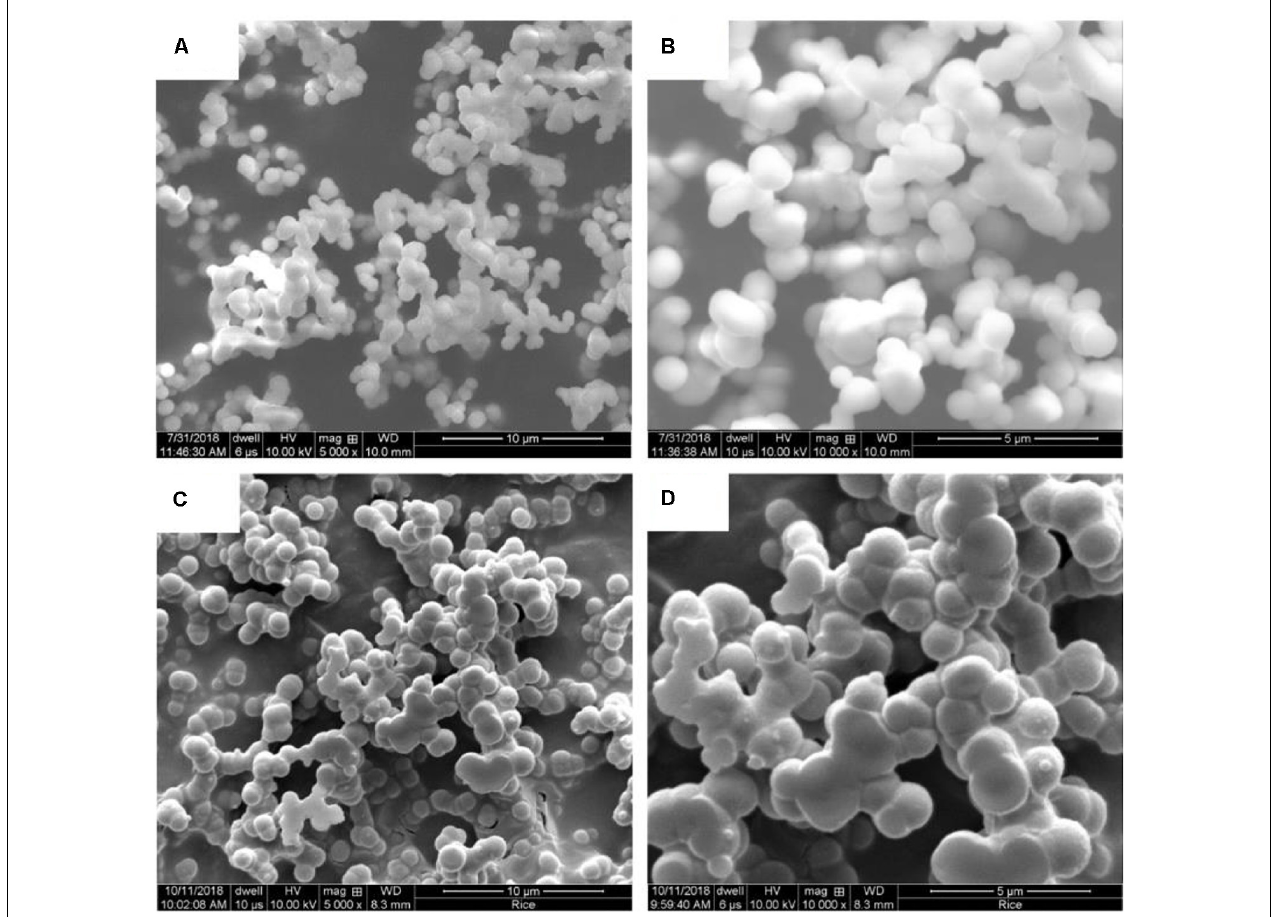
FIGURE 4 | SEM images of Ca-DTPMP particles prepared in the presence of (A,B) Na 3 Cit and (C,D)